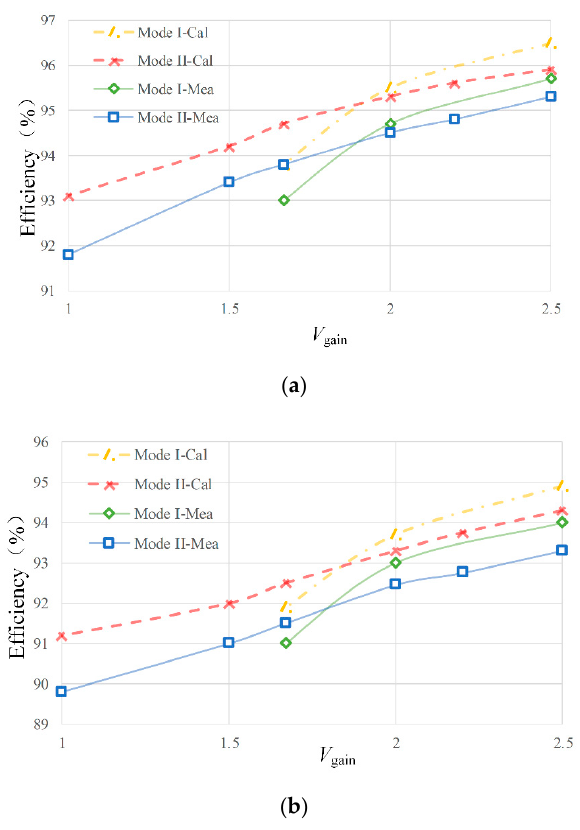
Figure 21. Efficiency curves of different modes ( a ) at 250 ( b ) at 100 W.